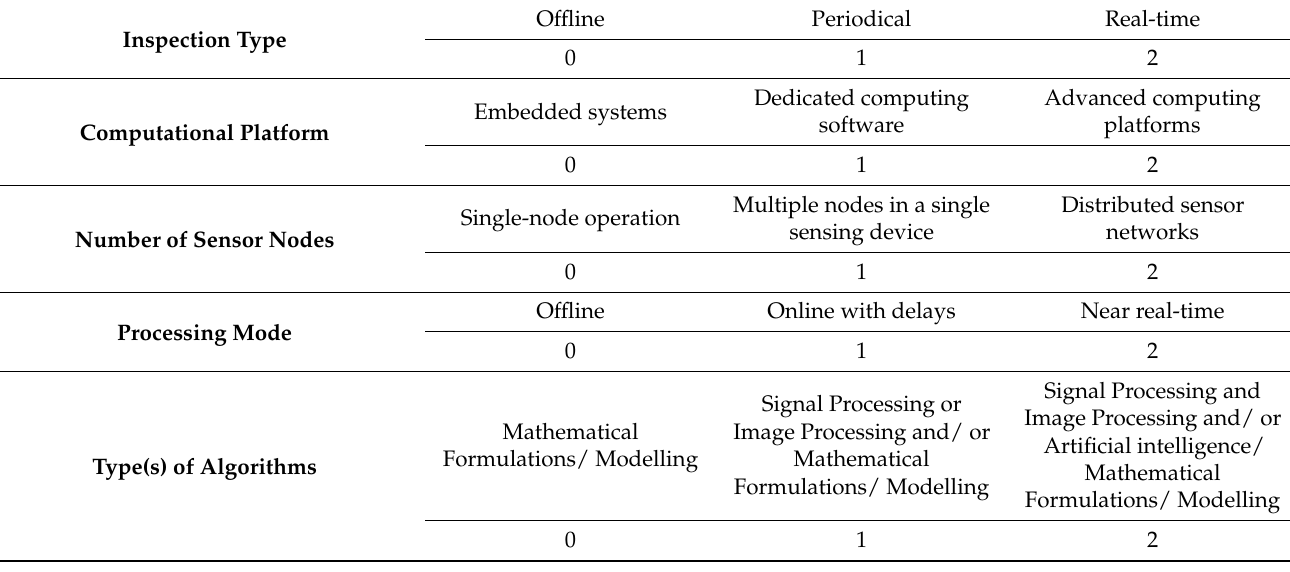
Table 4. Scoring matrix for computational